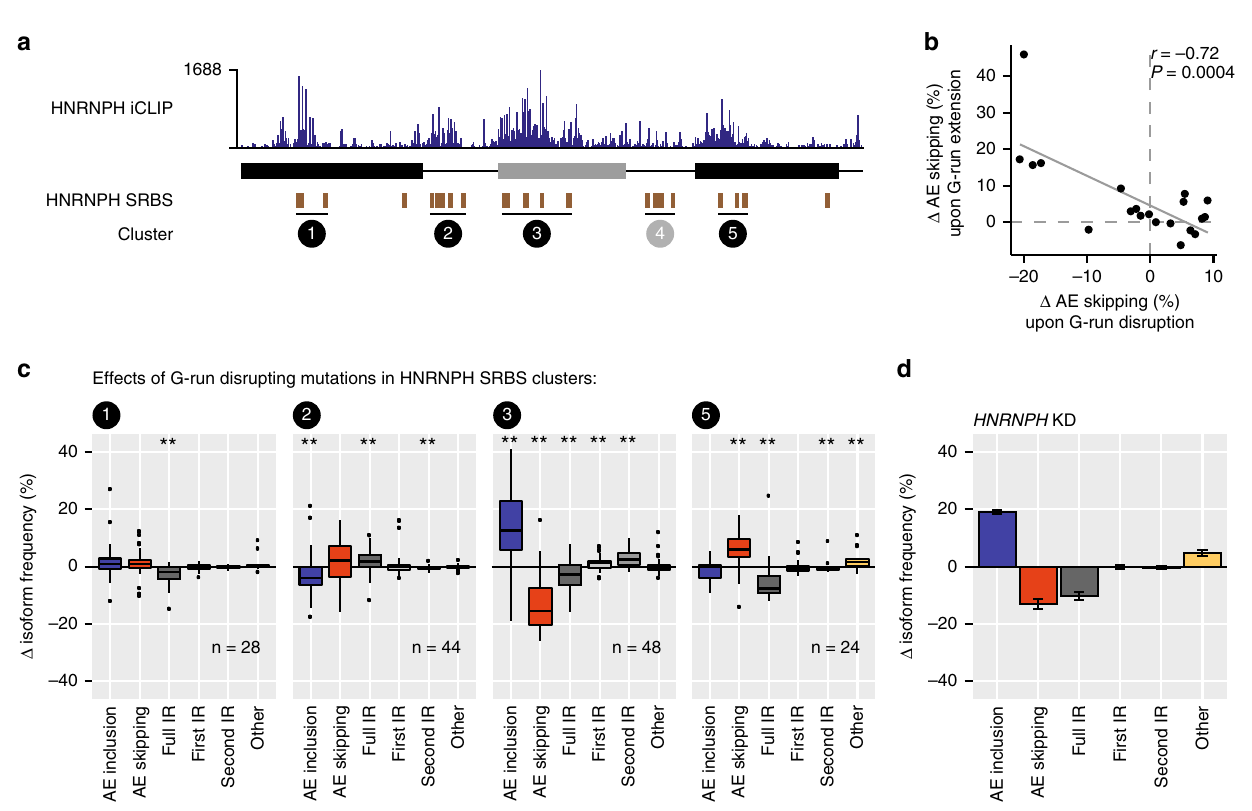
Fig. 4 HNRNPH controls RON exon 11 splicing via multiple intronic and exonic binding sites. a HNRNPH iCLIP validates HNRNPH binding to predicted splice-regulatory binding sites (SRBS). Bar diagram shows the number of HNRNPH crosslink events from HEK293T cells on each position along the wt RON minigene. HNRNPH SRBS (brown boxes) were assigned to fi ve SRBS clusters (circled numbers). iCLIP data show HNRNPH binding to four out of the fi ve SRBS clusters. b Extending or disrupting G-runs results in opposite splicing effects. Scatterplot shows inverse correlation of median changes in AE inclusion (average of three biological replicates) of all mutations per SRBS that extend or disrupt the G-run (see Methods) with linear regression line. r , Spearman correlation coef fi cient and associated P value. c Exonic and intronic HNRNPH binding exerts distinct effects on RON exon 11 splicing. Boxplots summarise the change in frequencies of each isoform in MCF7 cells (mean, n = 3) for all G-run-disrupting mutations within HNRNPH SRBS of different clusters (circled numbers). Box represents quartiles, centre line denotes 50th percentile and whiskers extend to most extreme data points within 1.5× interquartile range. Number of considered mutations for each cluster given below. * P value < 0.05, ** P value < 0.01, one-sample Wilcoxon test against population mean of zero. d Bar diagram shows the changes in isoform frequency of wt RON minigenes upon HNRNPH KD in MCF7 cells. Error bars indicate standard error